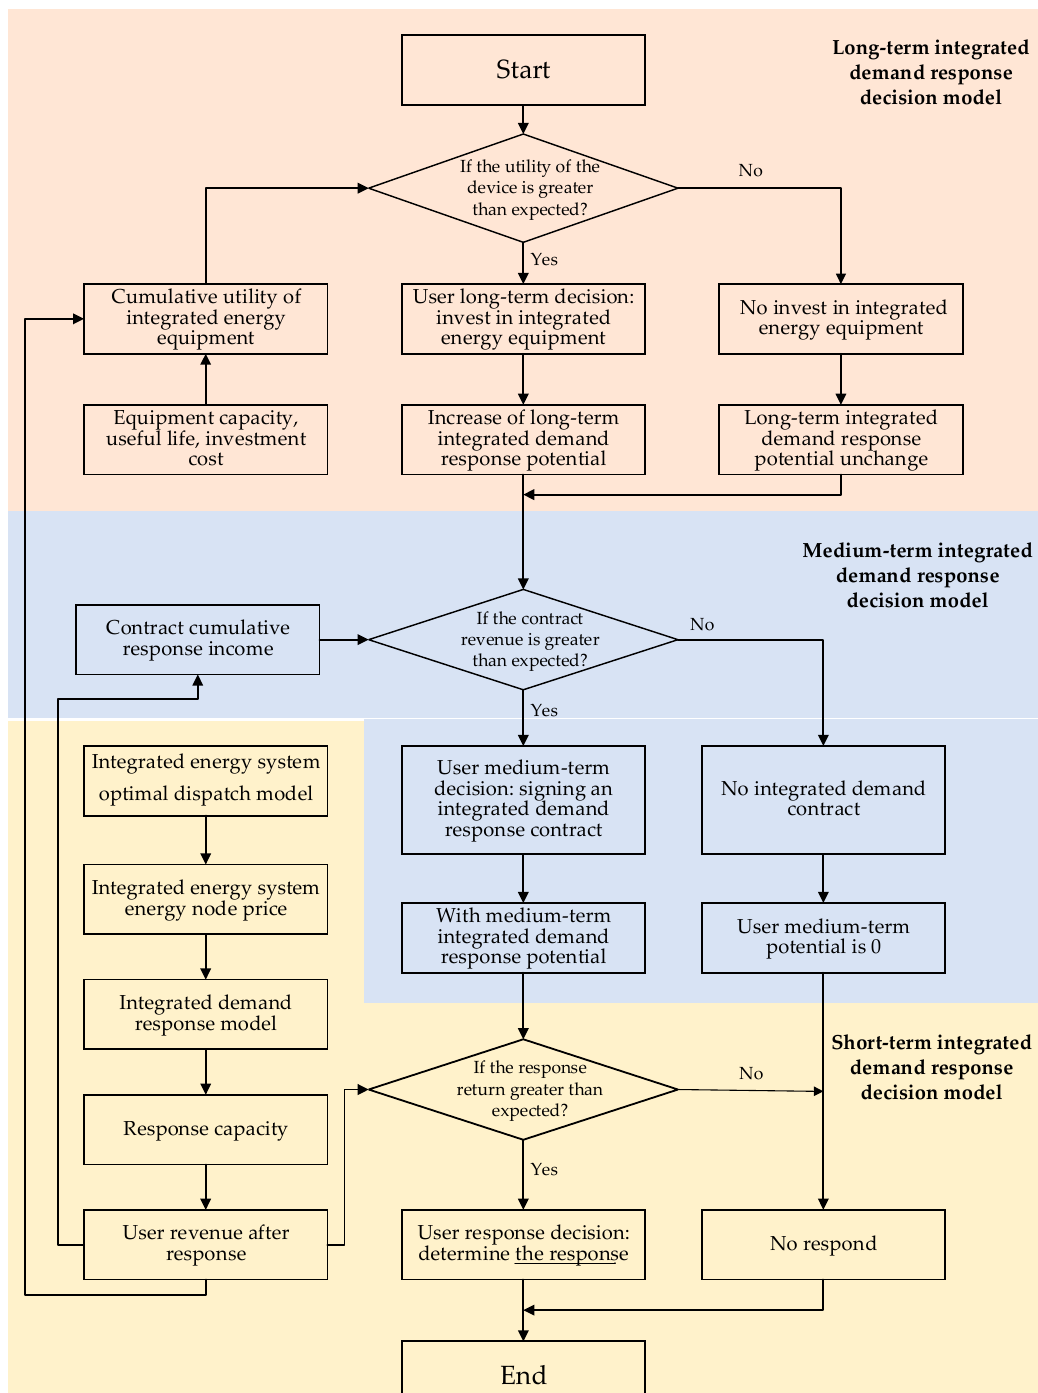
Figure 1. Medium- and long-term integrated demand response modeling process for integrated energy systems.